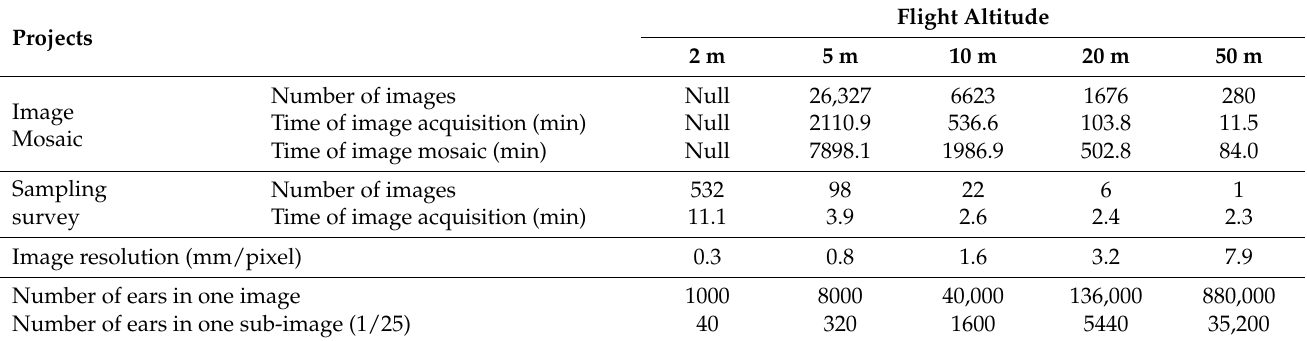
Table 4. Comparison of different survey modes of UAV in wheat ear number.